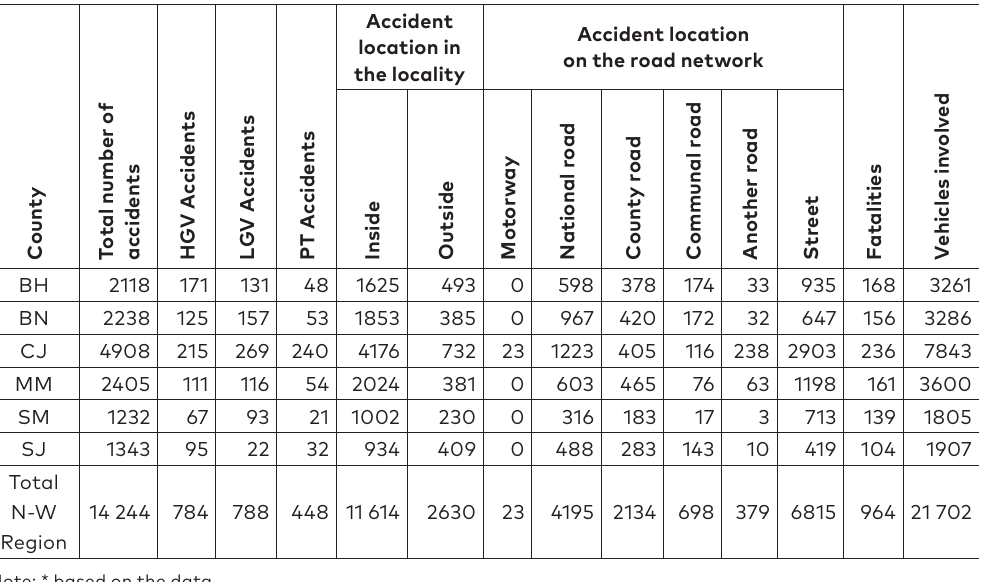
Table 3. Accidents database overview (source: author*, 2019)